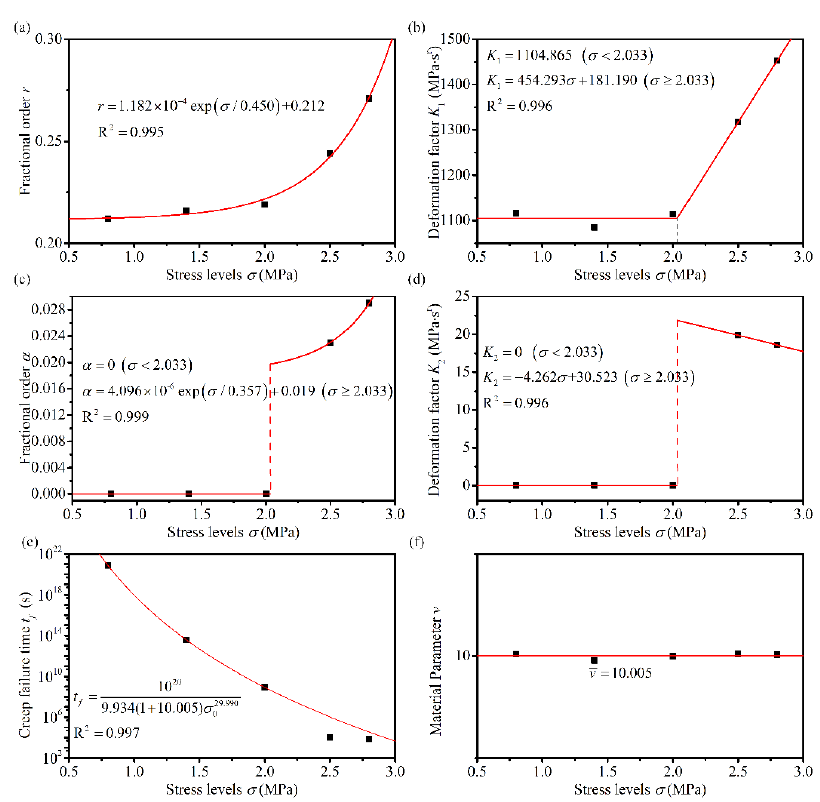
Figure 10. Variation of the proposed model parameters with stress levels at 10 °C ( a ) r , ( b ) K 1 , ( c ) α , ( d ) K 2 , ( e ) t f , and ( f ) v .